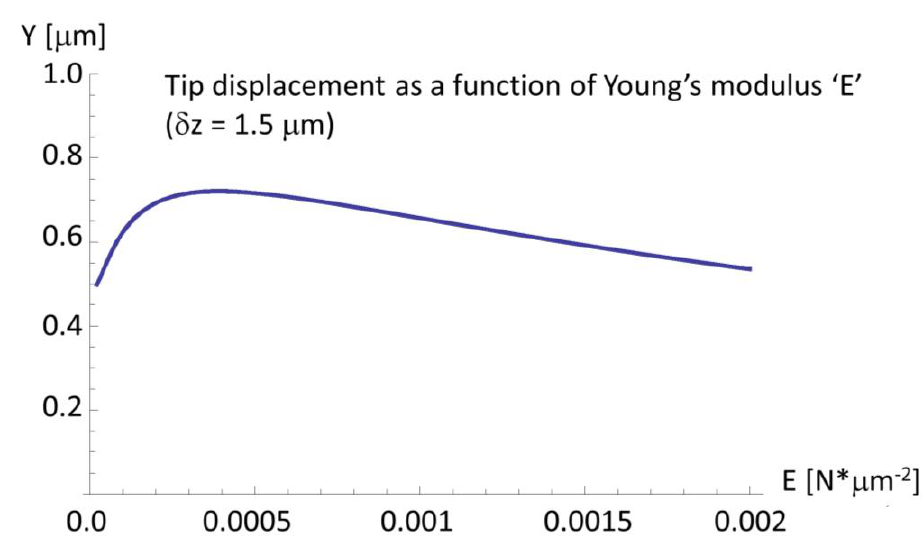
Figure 7. Example deformation of a primary cilium for a representative experiment, showing the effect of varying the horizontal displacement of the trap from the cilium axis δy. Data graphs the displacement of the cilium tip Y(3). The trap parameters: incident power P = 0.5 W, trapping lens numerical aperture NA = 0.95, and trap wavelength λ 0 = 1.064 µm. The trap center was displaced from the cilium axis by δz = 1.5 µm. The cilium length is 3.0 µm.